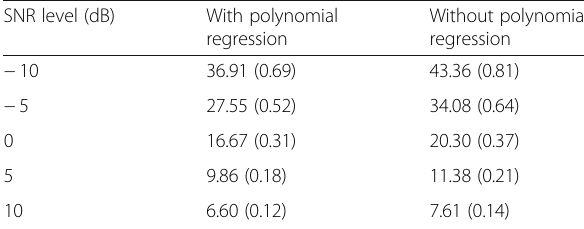
Table 4 Results of the proposed algorithm with and without the polynomial regression using GMM-UBM method. Female data degraded with the lynx noise are used SNR level (dB)